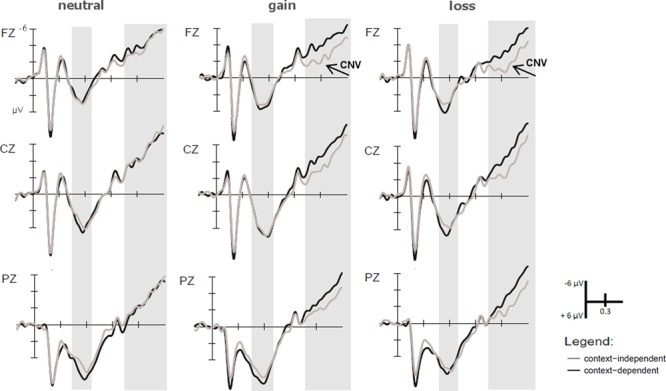
ERPs time-locked to the context cue. Marginally larger P3b amplitudes were found for gain than loss blocks in the time window ranging from 450 to 650 ms after context cue onset at central electrodes (Cz) only. In the time window from 1000 to 1500 ms, CNV amplitudes were larger for gain than loss cues at frontal (Fz) electrodes.